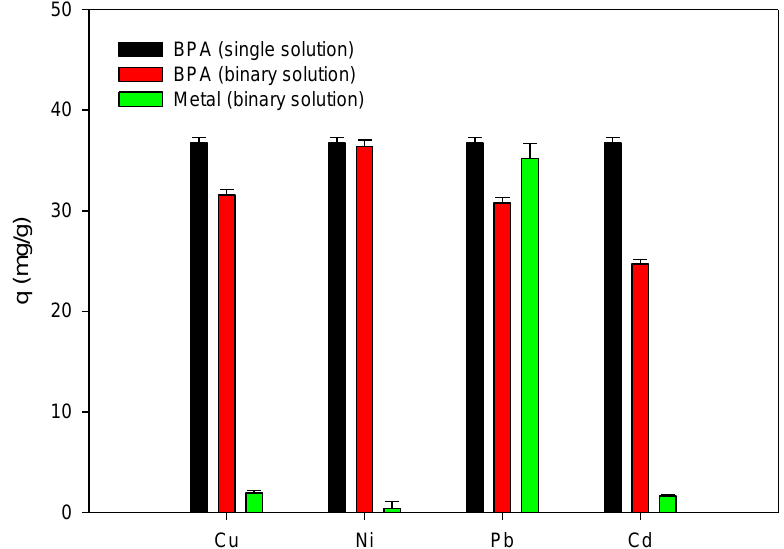
Figure 8. BPA adsorption capacity in single solutions (black color) and in binary solutions with the different heavy metals (green marker for metal and red one for BPA) using activated carbon AC-40 as the adsorbent.